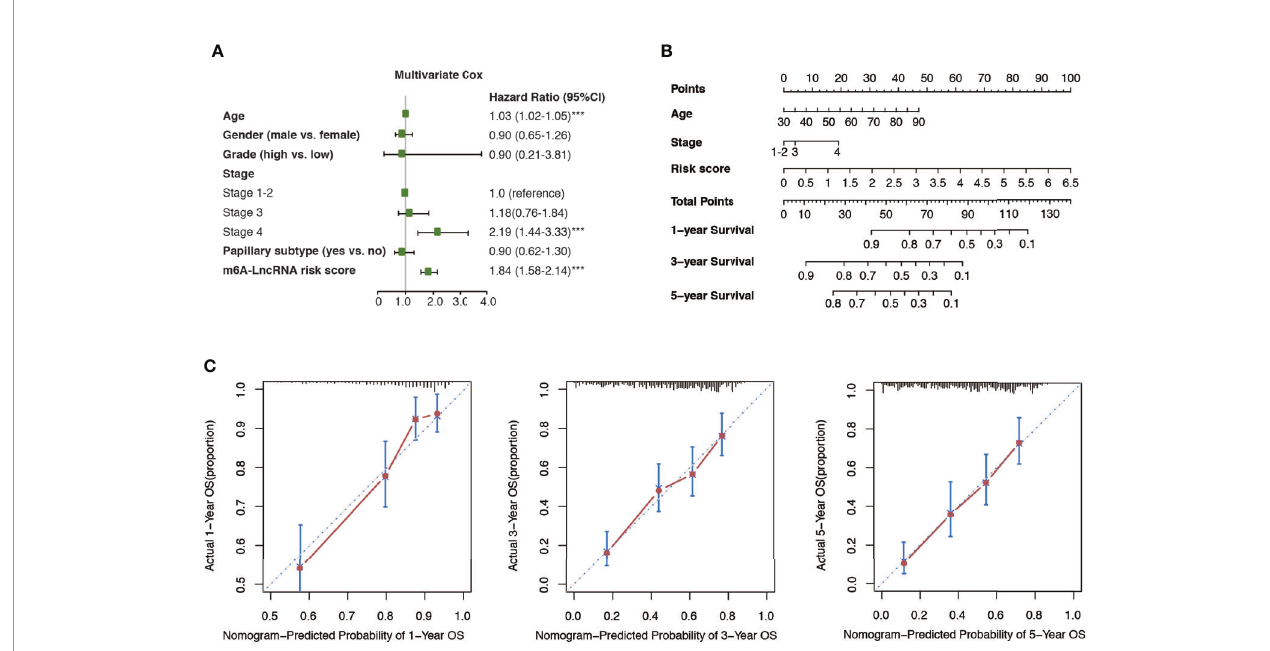
FIGURE 4 | Construction of m6A-LRS nomogram. (A) Multivariate Cox regression revealed that the m6A-related lncRNA risk score (m6A-LRS) was an independent prognostic predictor of overall survival in the TCGA dataset. ***P < 0.001. (B) Nomogram based on the age, clinical stage, and m6A-LRS. (C) Calibration plots of the nomogram for the prediction of overall survival at 1, 3, and 5 years in the TCGA